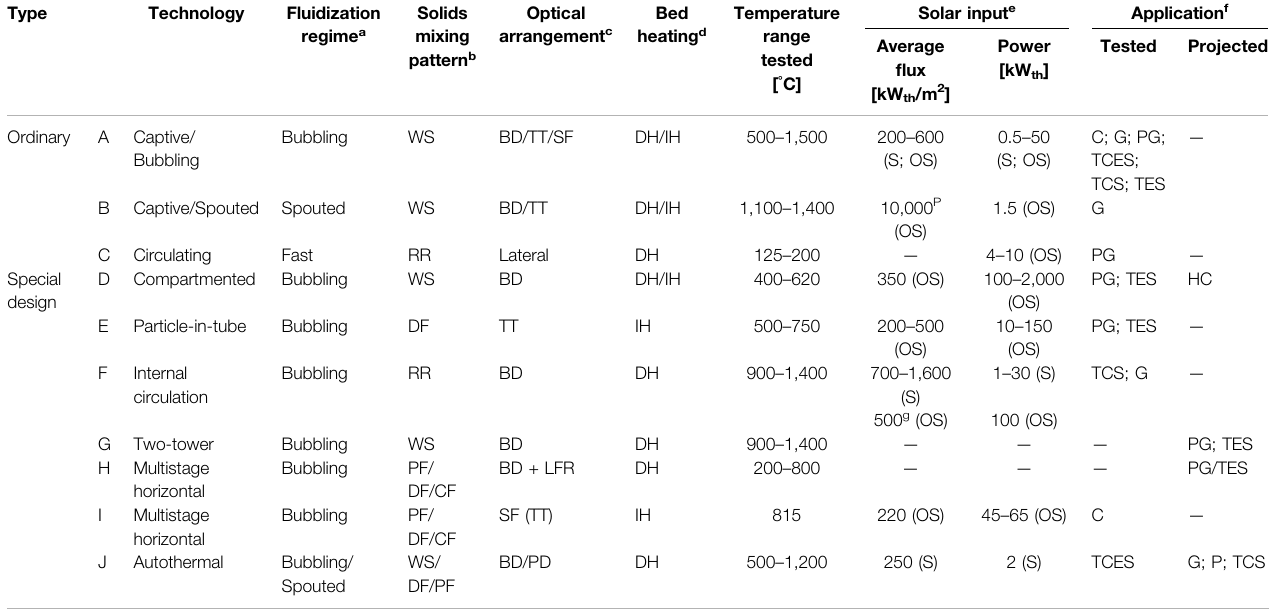
TABLE 1 | Outline of fl uidized bed technologies for CSP